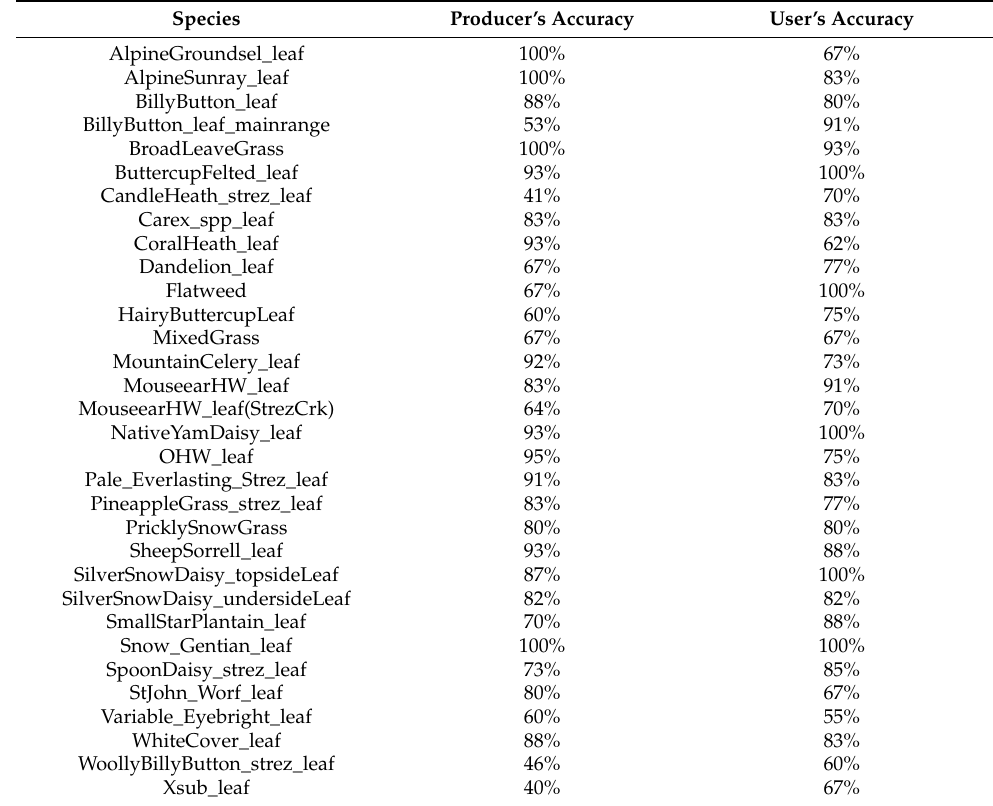
Figure 6. Average spectral profiles collected by the spectroradiometer with leaf clip during the Jan/Feb 2018 surveys. Table 4. Summary of the confusion matrix of the Random Forest classification for the spectral profile data of leaves only collected with the leaf